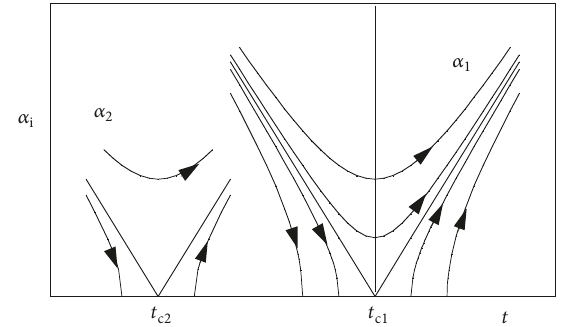
Figure 3: Renormalization group flow as 𝜇 󳨀→ ∞ for 𝛼 1 and 𝛼 2